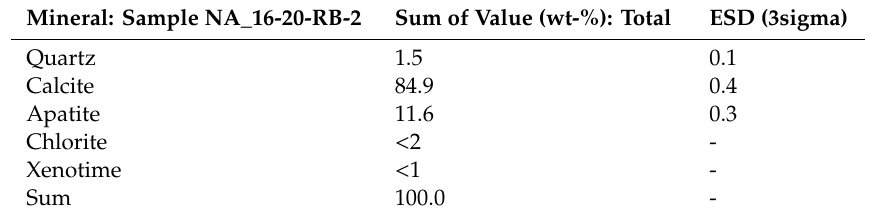
Table 5. XRD results of field sample taken from D2 at validation point 2 shown in Figure 12A.